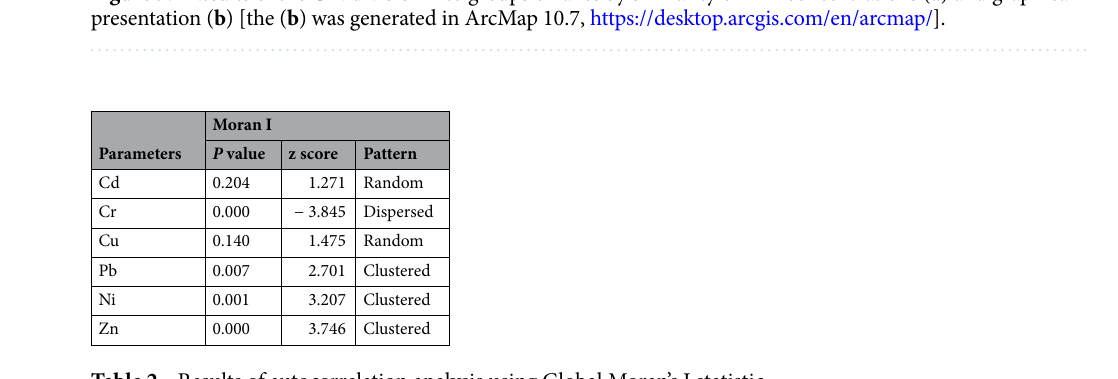
Table 2. Results of autocorrelation analysis using Global Moran’s I